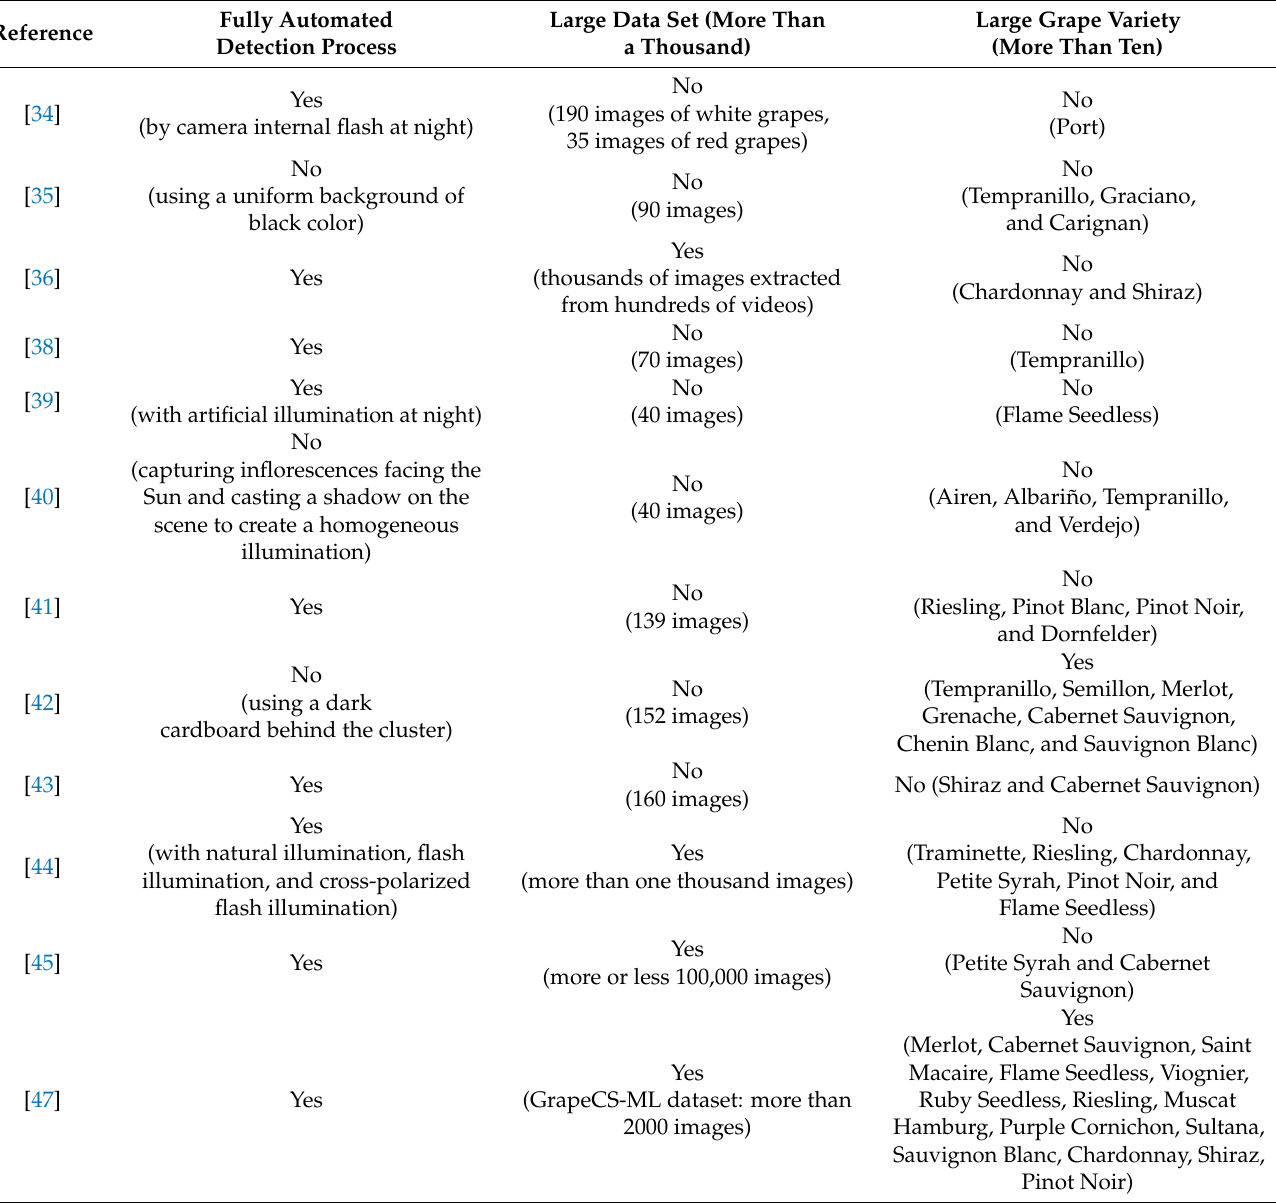
Table 1. Comparison between the main characteristics of grape detection proposed